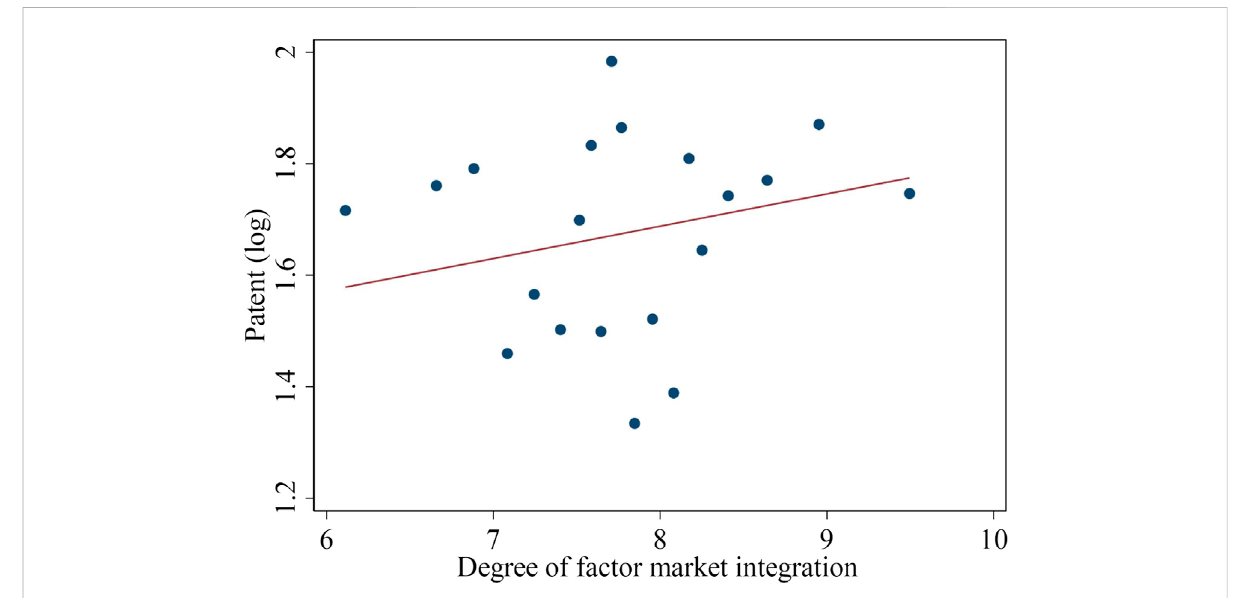
FIGURE 3 Correlation between factor market integration and green patents.